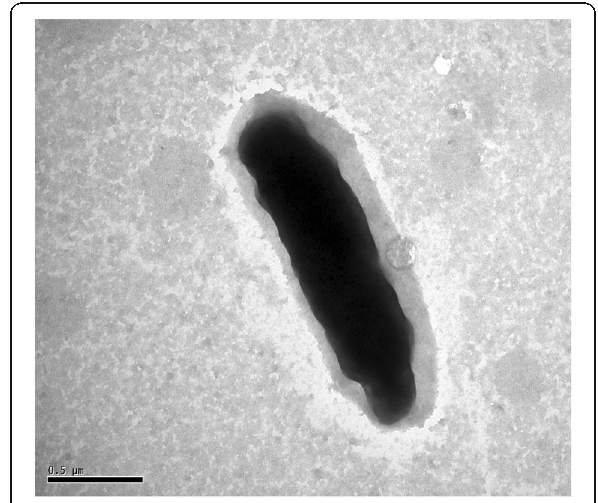
Fig. 2 Transmission electron micrograph image of strain JH-7 T